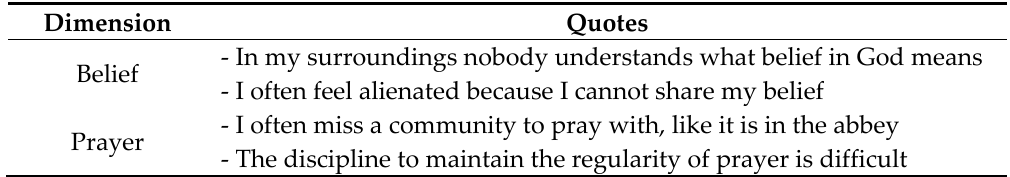
Figure 4. Problems of ritual transfer—quotes.